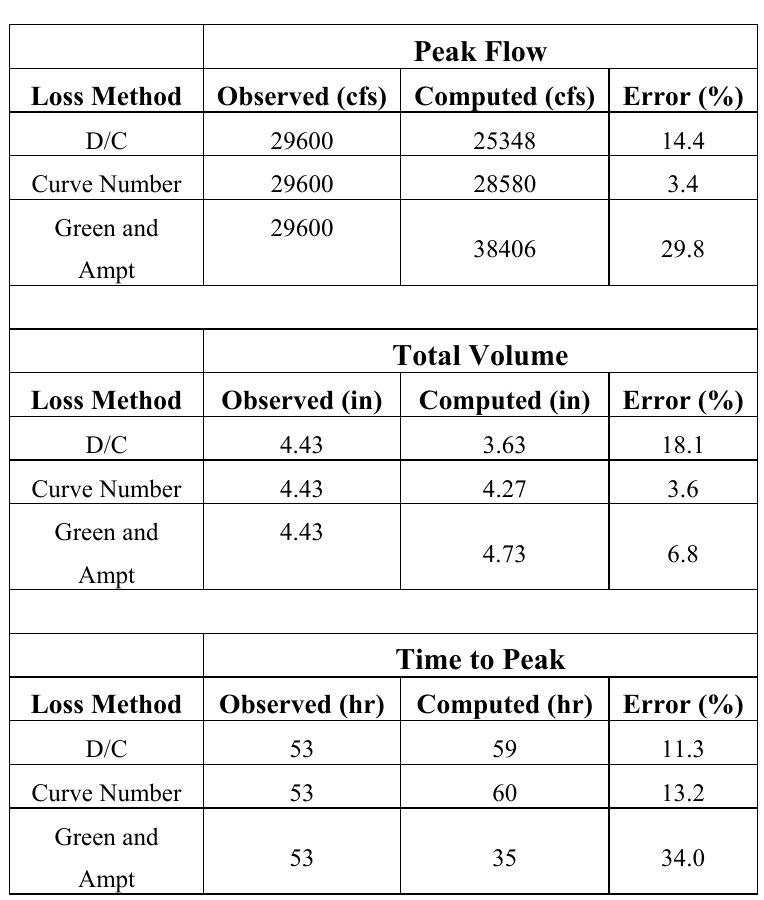
Table 3. Streamflow error statistics using bias-adjusted satellite rainfall